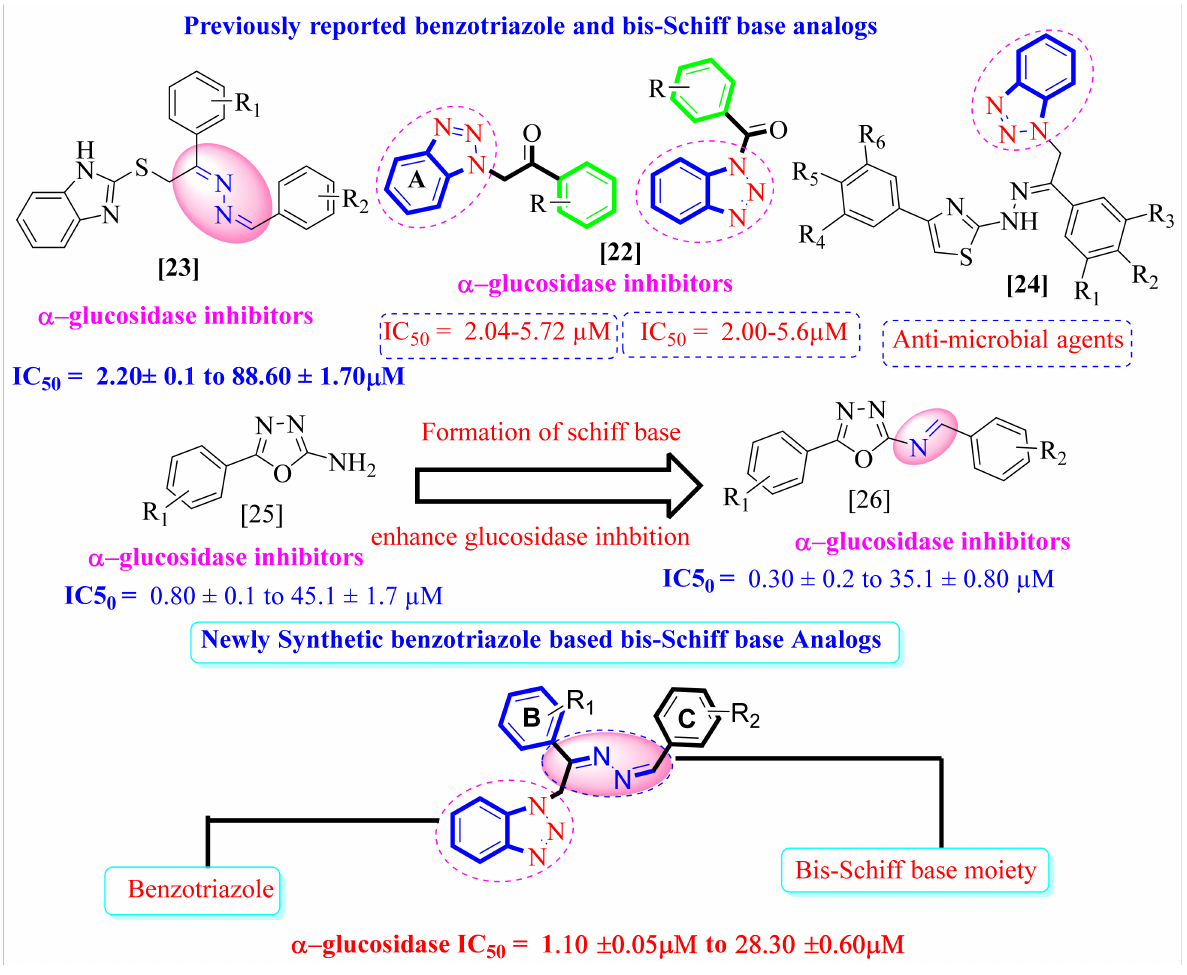
Figure 1. Rationale of the current